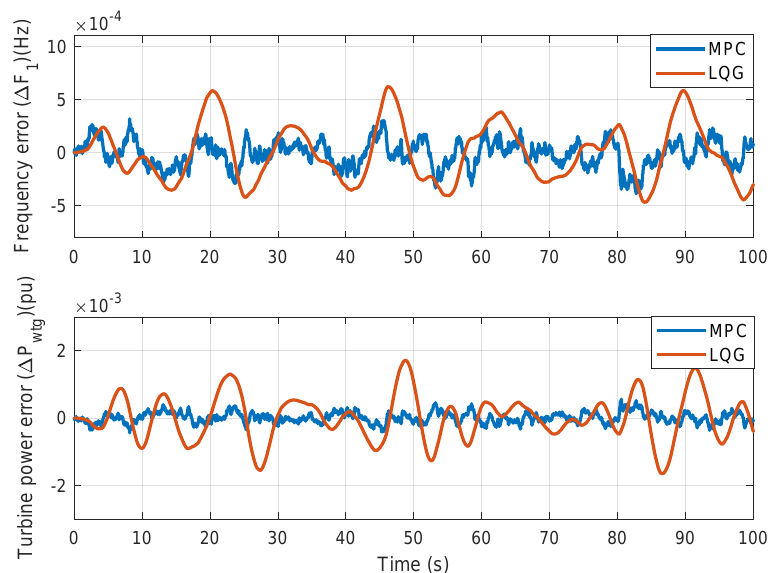
Figure 8. Performance of the proposed decentralized MPC and the benchmark decentralized LQG controllers in terms of the frequency and turbine power errors subject to random load and wind power disturbances shown in Figure 7.